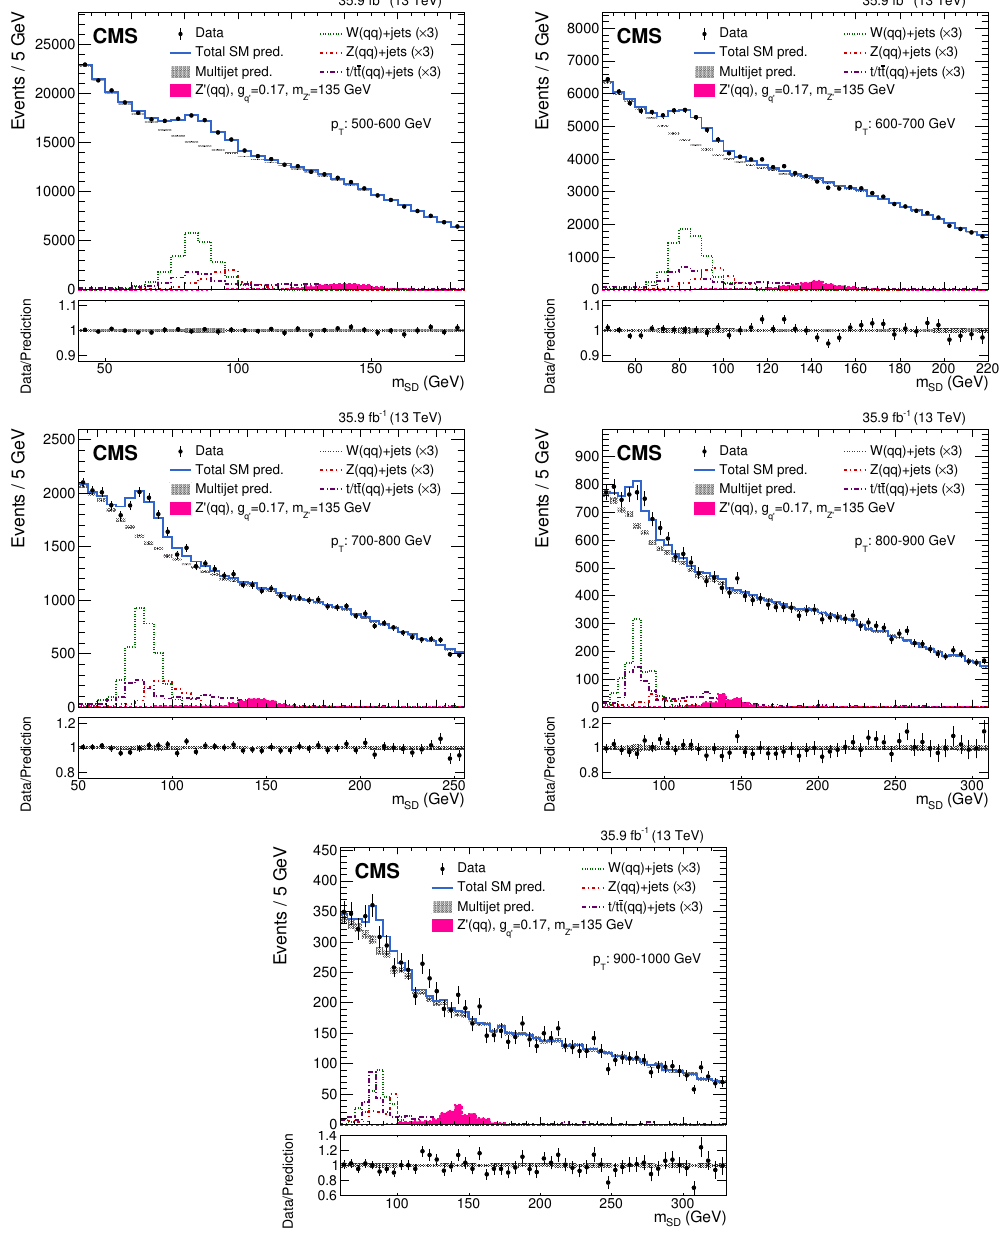
Figure 6 . Soft-drop jet mass distribution for the di(cid:11)erent p T ranges of the (cid:12)t from 500 to 1000 GeV. Data are shown as black points. The multijet background prediction, including uncertainties, is shown by the shaded bands. Contributions from the W and Z boson, and top quark background processes are shown, scaled up by a factor of 3 for clarity. A hypothetical Z 0 boson signal at a mass of 135 GeV is also indicated. In the bottom panel, the ratio of the data to the background prediction, including uncertainties, is shown. The scale on the x-axis di(cid:11)ers for each p T range due to the kinematic selection on (cid:26) .